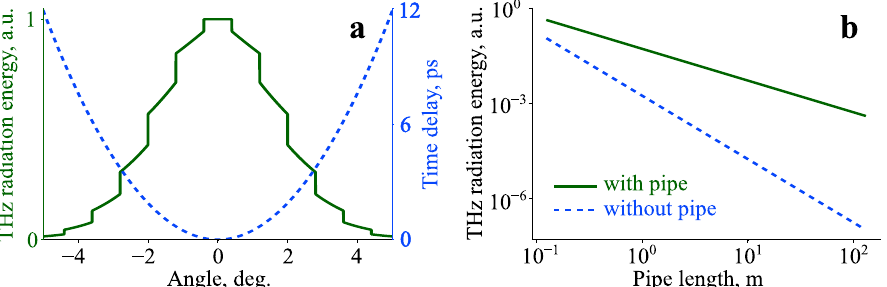
Figure 5. Terahertz radiation angular distribution at the pipe output (green solid line) and delay of the terahertz pulse depending on the propagation angle (blue dashed line) ( a ). Energy of terahertz radiation contained in the aperture corresponding to the pipe diameter depending on the distance for free propagation and propagation in the pipe ( b